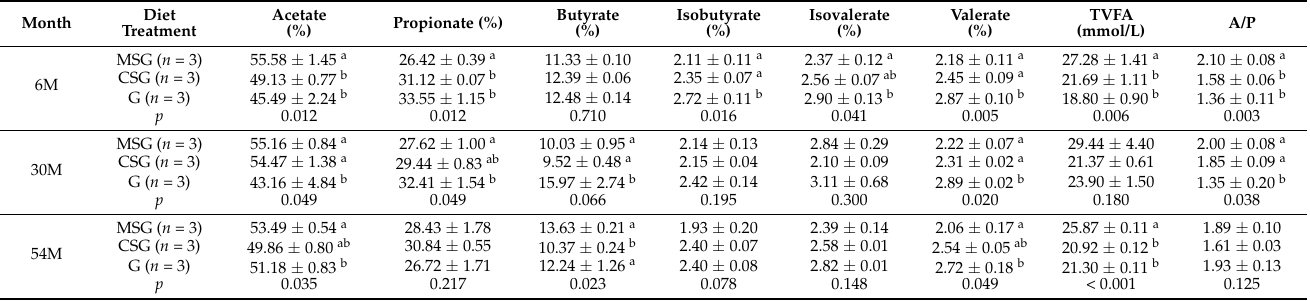
Table 6. The level of VFAs in the ruminal fluids of Tianzhu white yaks supplemented with various diets.